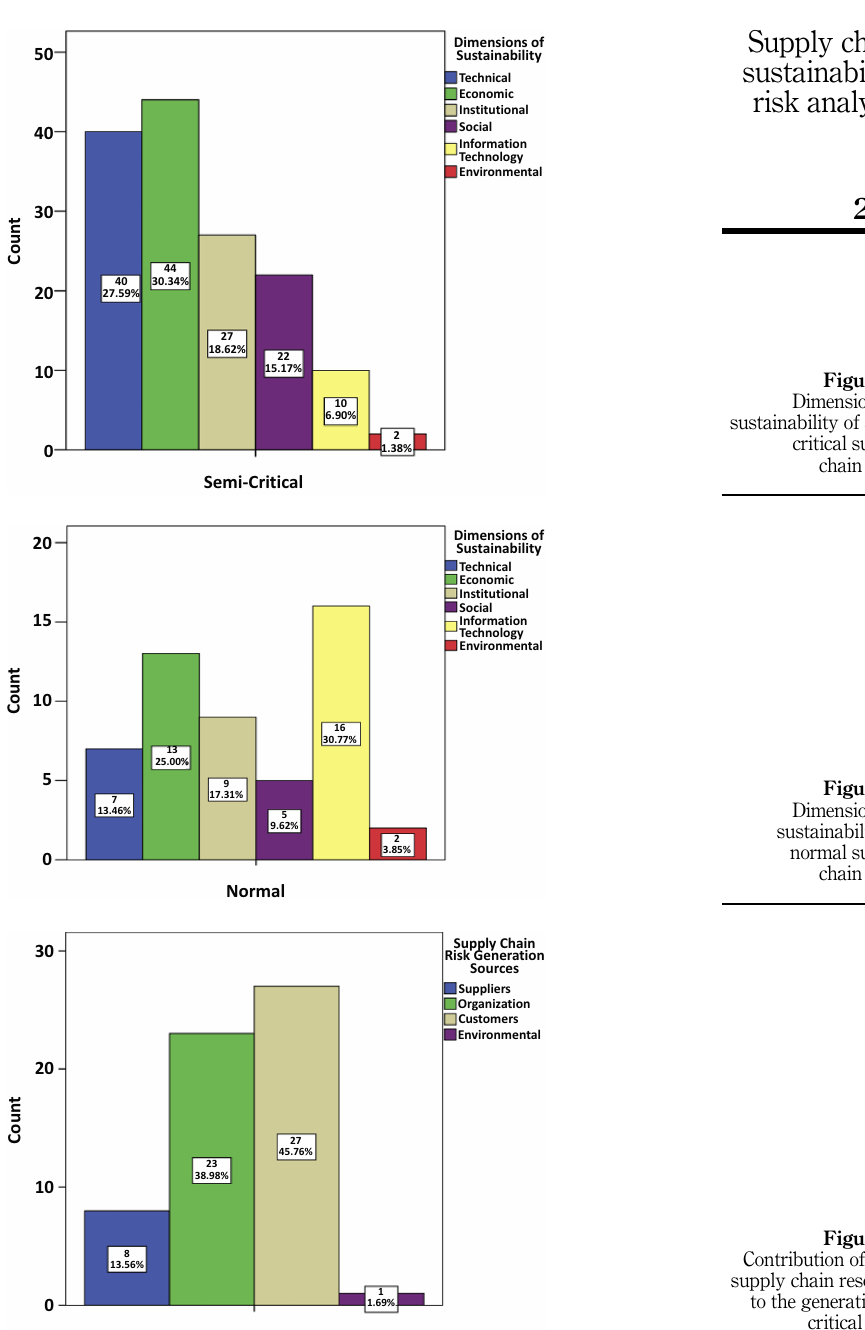
Figure 8. Contribution of each supply chain resource to the generation